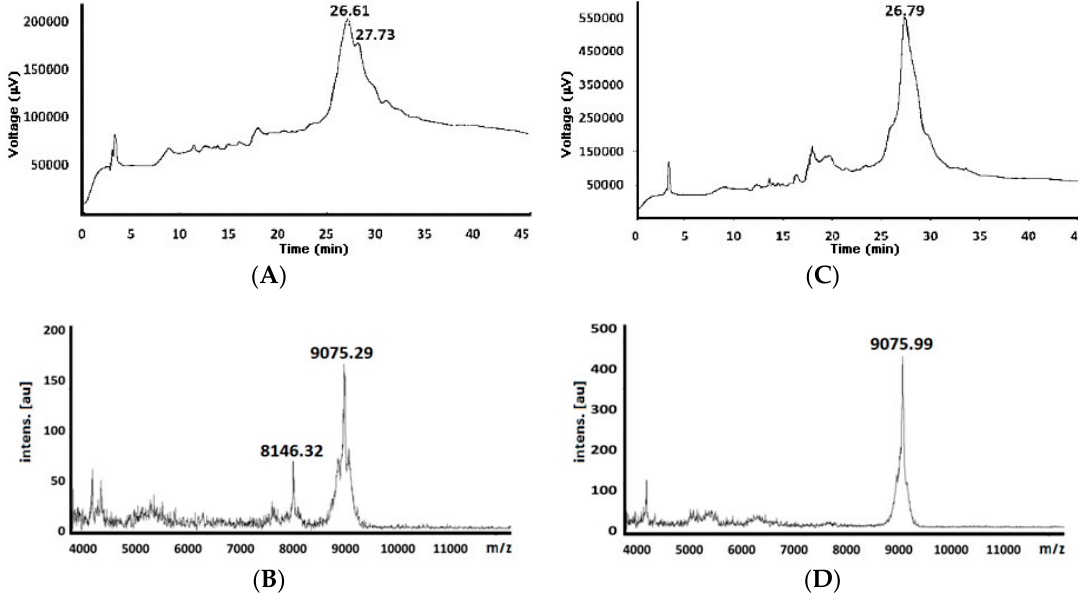
Figure 1. Chromatographic profiles and mass spectra for crude peptide’s 82nd residue (theoretical 9051.42 Da) obtained by standard ( A ) and ( B ) (Chromatogram and mass spectra, respectively) and MW-assisted reaction conditions ( C ) and ( D ) Chromatogram and mass spectra, respectively).